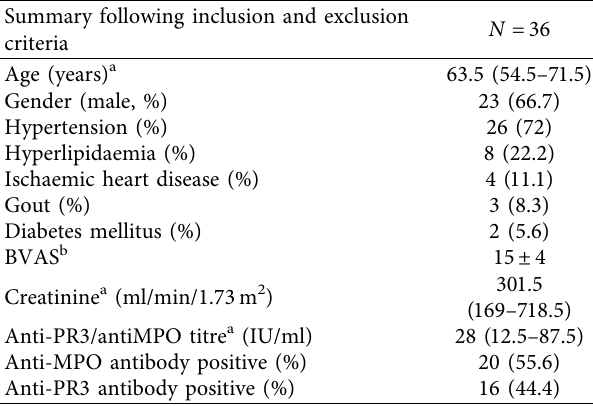
Table 1: Baseline demographics and laboratory values at presentation.